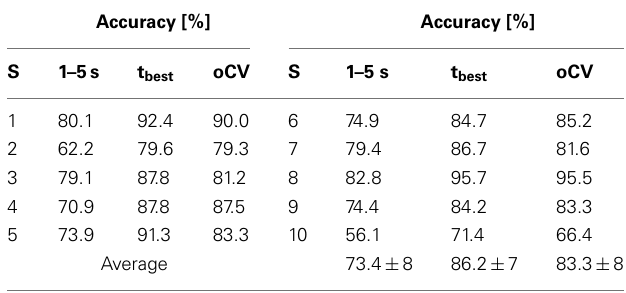
For each subject, one to four features were chosen individually. These were band-powers in frequency bands recorded on the three bipolar channels.